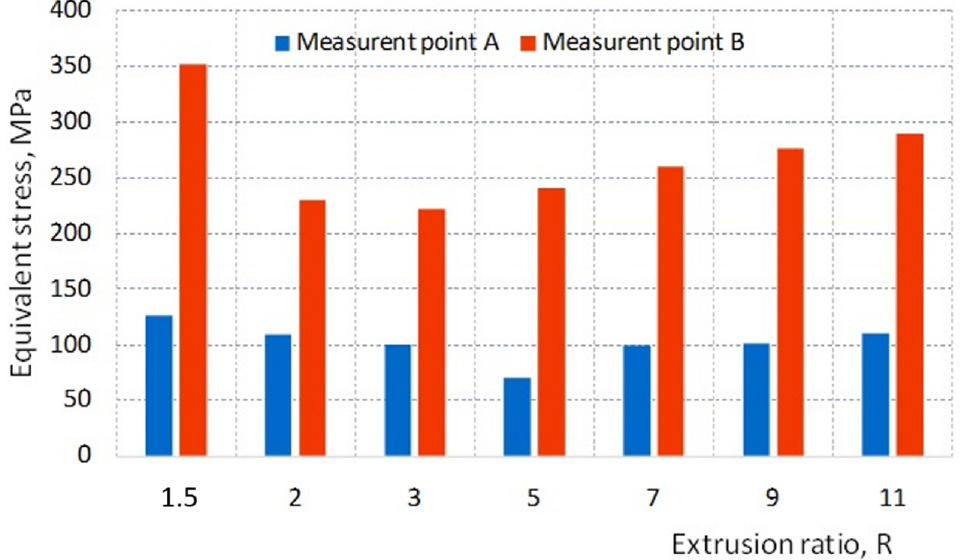
Figure 7. The impact of extrusion ratio R on the value of Huber–Mises stress at measuring points A and B on the longitudinal section of the die.